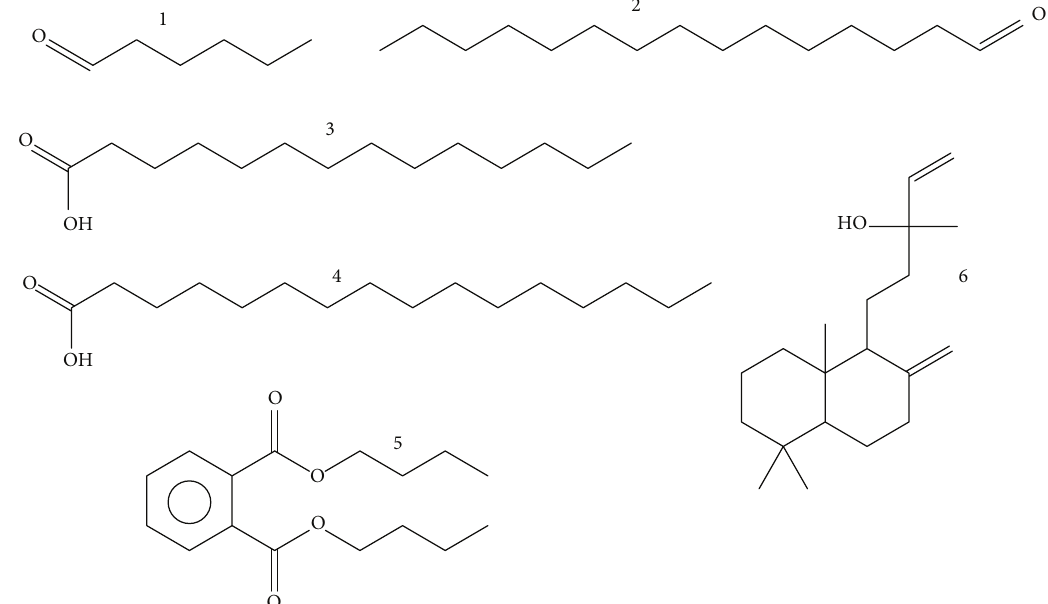
Figure 1: Structure of hexanal (1), pentadecanal (2), tetradecanoic acid (3), hexadecanoic acid (4), dibutyl phthalate (5), and manool (6).